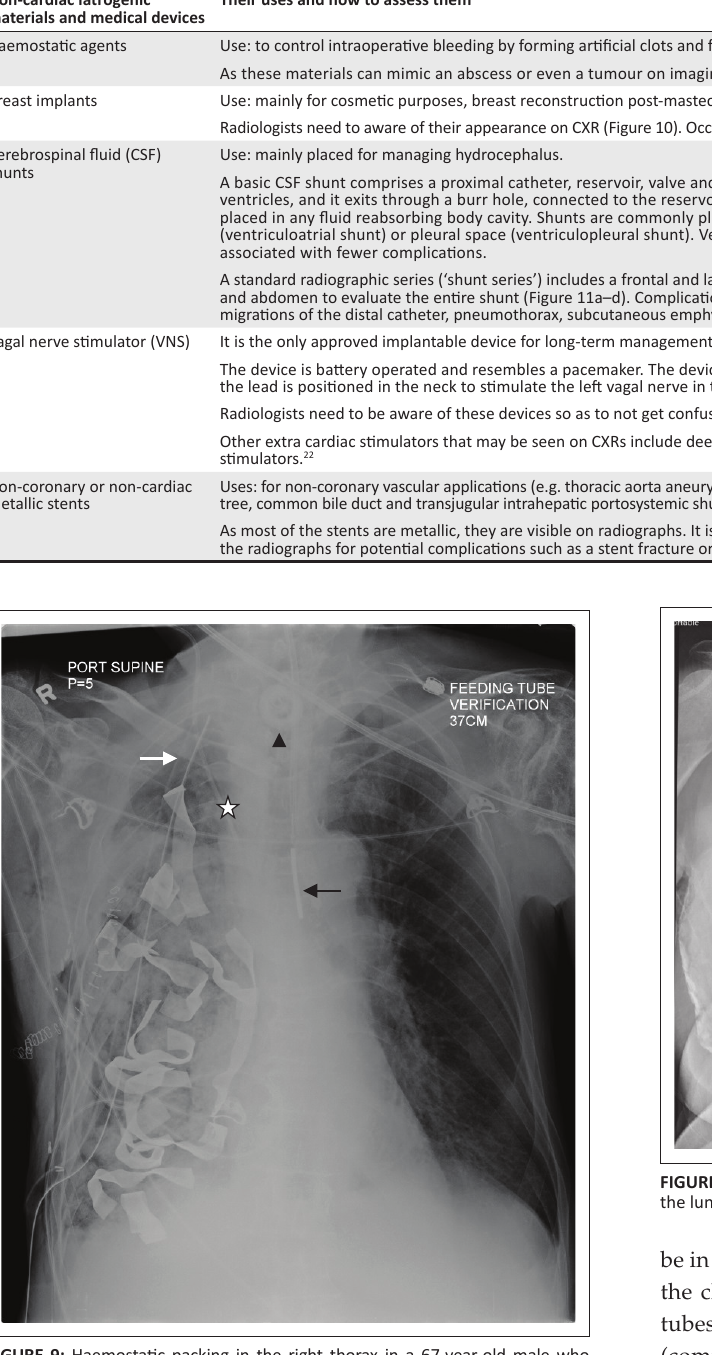
FIGURE 9: Haemostatic packing in the right thorax in a 67-year-old male who underwent pneumonectomy. In addition, visualised are a tracheostomy tube (arrow head), a malpositioned Dobhoff tube (black arrow) in the mid-oesophagus, a right central venous catheter with its tip in the mid-SVC (star) and an intercostal drainage tube (white arrow).